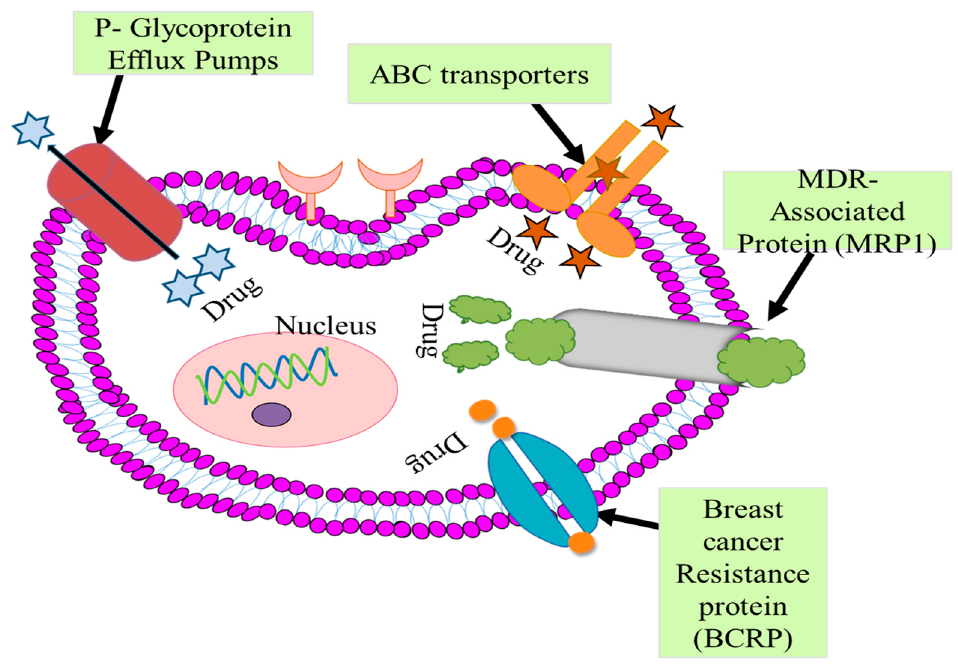
Figure 2. An overview of various transporter proteins: P-glycoprotein, ABC transporter, MDR-associated protein (MRP1), and breast cancer resistance protein (BCRP) are transporter for lipids, proteins, toxins, and sterols. These transporters show broad drug specificity and transport various anticancer drugs, causing lowering drug concentrations in tumor cells and thus reducing drug efficacy. All these transporters contribute to resistance to cancer chemotherapy.